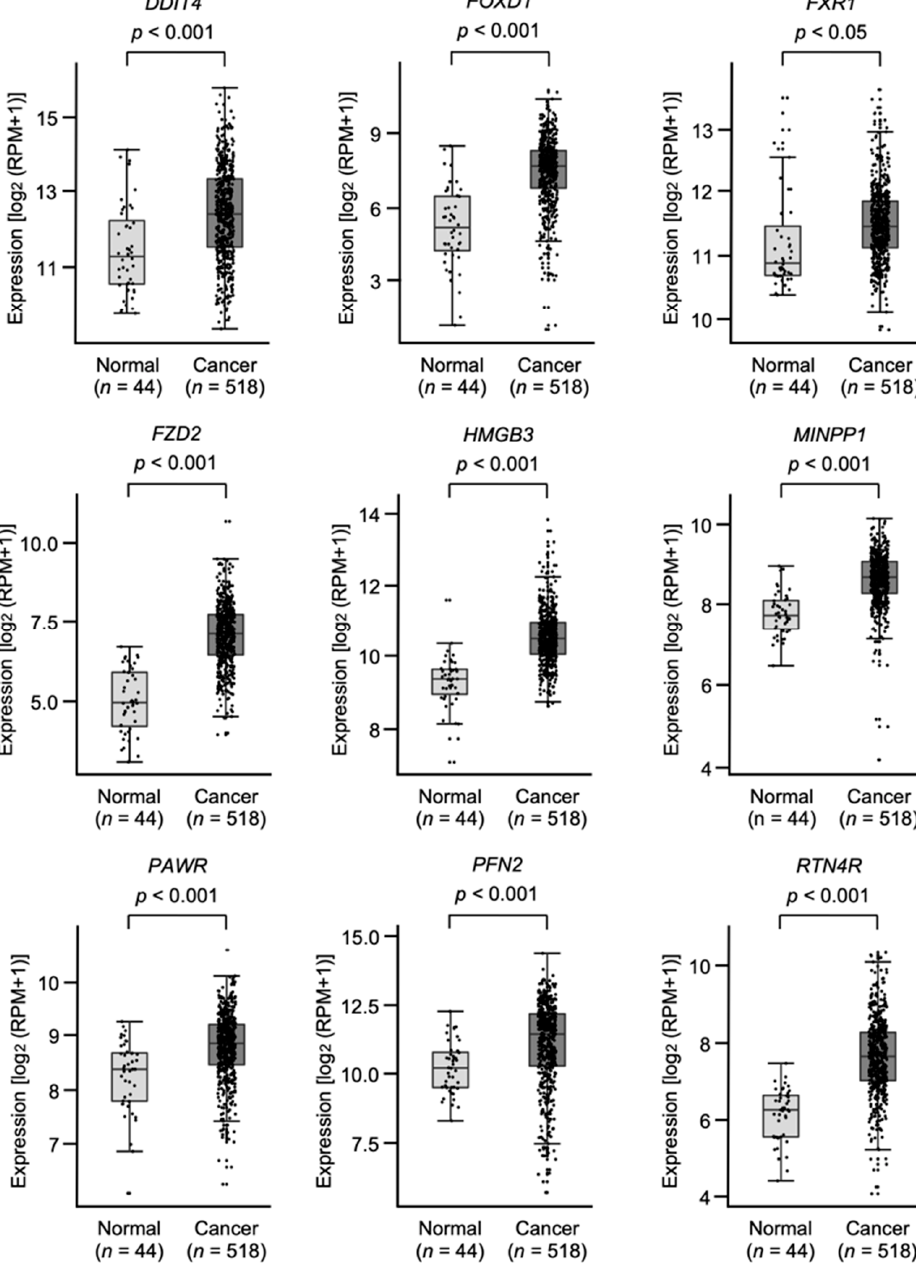
Figure 6. Expression levels of nine target genes ( DDIT4 , FOXD1 , FXR1 , FZD2 , HMGB3 , MINPP1 , PAWR , PFN2 , and RTN4R ) in HNSCC clinical specimens from TCGA-HNSC. All genes were found to be upregulated in HNSCC tissues ( n = 518) compared with normal tissues ( n = 44).